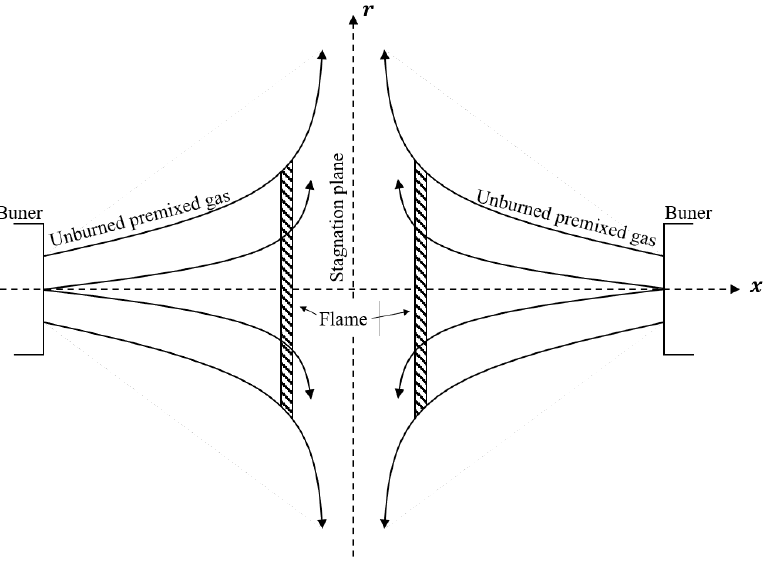
Figure 10. Schematic of counterflow premixed flame experiment.